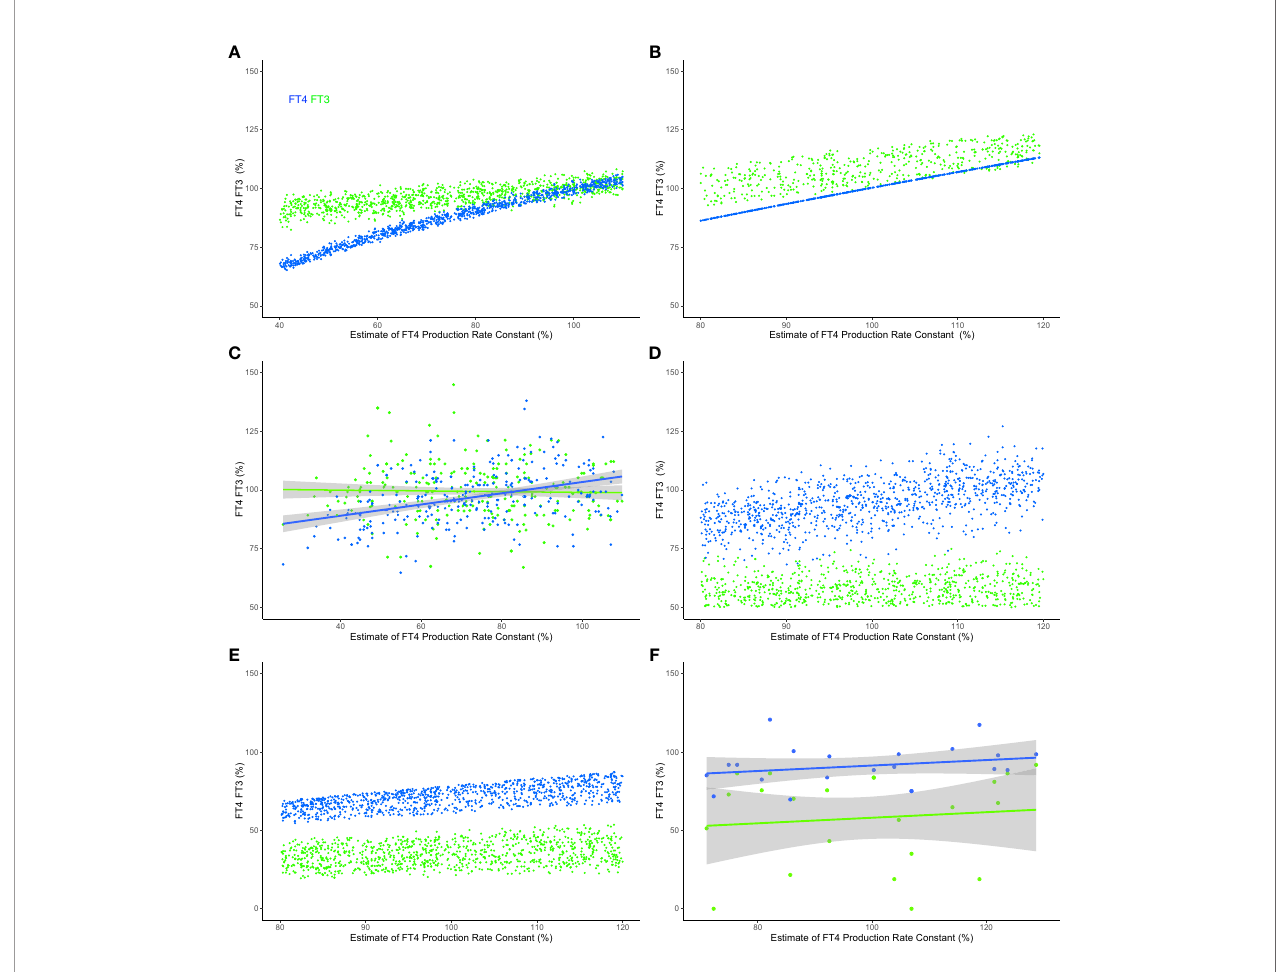
FIGURE 6 | Modeled and clinical outcomes of FT3 homeostasis and FT3 adaptation. (A) FT4 levels (blue curve) decline, but the mechanisms in system (sys. 10) protect FT3 levels (green curve), keeping them in a range close to the original level, as the percentage of the estimate of FT4 production rate constant (k32 = 0.4- 1.1) decreases - as typical at the onset of hypothyroidism in patients suffering from autoimmune thyroiditis and progressive thyroid destruction. Other parameters are chosen within ranges, k423 = 0.2-0.3, k43 = 0.7-0.8 and k42 = 0.1-0.2, to approximate the relative contributions to FT3 production according to (32). (B) The predictions of a physiologically-based molecular model (32) are comparable with those of the minimal model, as the percentage estimate of FT4 production rate constant (termed v0 in this model) decreases. (C) The FT3 and FT4 solutions predicted by the models were clinically observed in a sample of patients with thyroid autoimmune disease (31). In the clinical data, a percentage estimate of FT4 production rate constant is obtained by normalizing the maximum secretory capacity of the thyroid gland (termed GT) (31). (D) The levels of FT3 are low, as the percentage estimate of FT4 production rate constant (k32 = 0.8-1.2) varies, and multiple other rate constants, k423 = 0.2-0.3, k43 = 01-0.4, k42 = 0.1-0.2, s1 = 0.2-0.8 and c2 = 0.2-0.8, simultaneously decrease - as is typical in the severe non- thyroid illness syndrome. (E) The physiologically-based molecular model (32) predicts a similar outcome, and (F) the model predictions are clinically observed in a sample of critically ill patients in intensive care (33). For the clinical data in panels (C, F) , indicative regression lines with 95% con fi dence intervals are shown. To permit a comparison across the different models and clinical data, estimates of production rate constant and the levels of FT3 and FT4 are scaled, normalized for each model and normalized mean centered for the data using a euthyroid sample, and expressed as a percentage of the normalized level. Full details are provided in Supplementary Material . Color code of hormones: FT4 blue, FT3